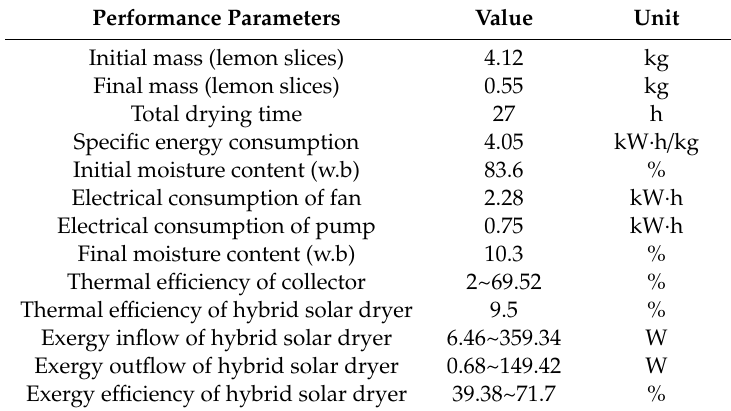
Table 6. Performance parameters of hybrid solar dryer for drying lemon slices.